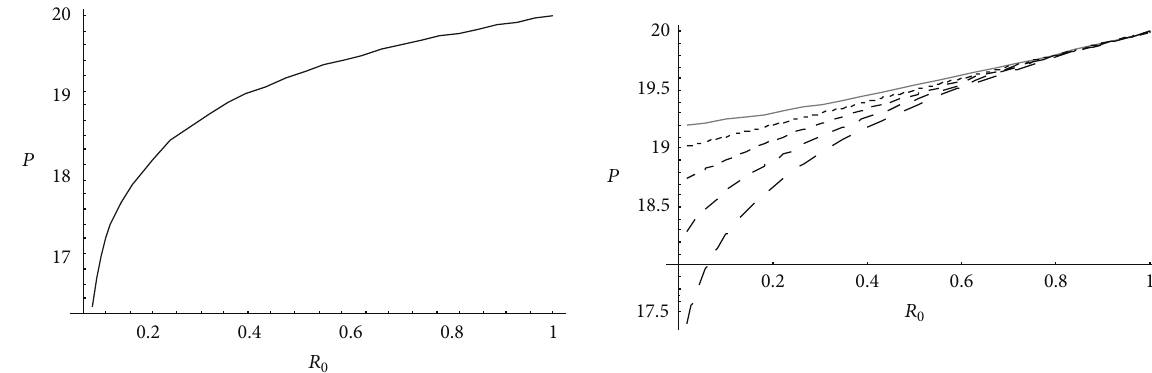
Figure 4: External or internal pressure required for fully plastic state for homogeneous and nonhomogeneous circular cylinder (internal or external = 20) for different compressibility parameters.